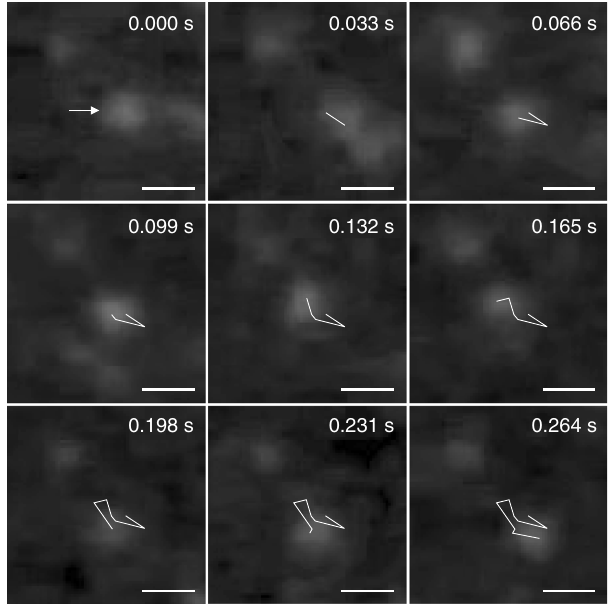
Fig. 5 Localization of multiblock amphiphile in plasma membrane. Snapshots of total internal re fl ection fl uorescence microscopic